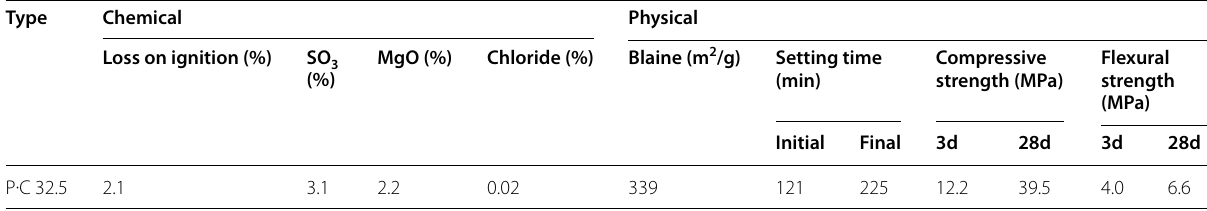
Table 1 Chemical and physical properties of the cement.